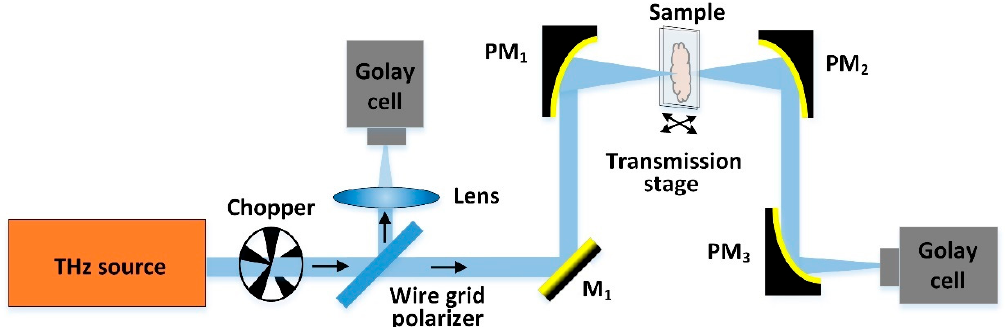
Figure 1. Continuous-wave (CW)-THz single-point scanning imaging system. PMs, off-axis parabolic mirrors; M 1 , THz gold mirror.